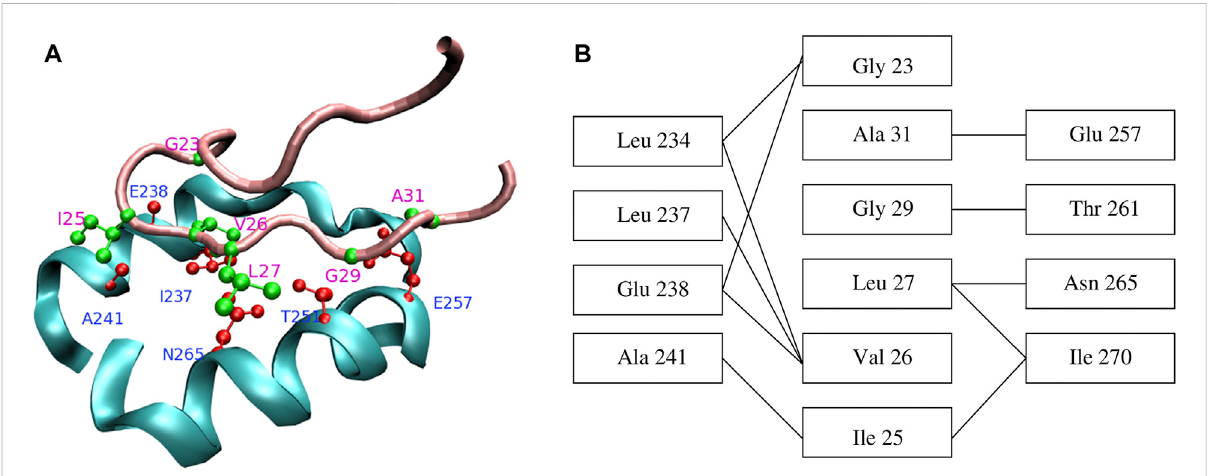
FIGURE 4 (A) Contacts between GroEL helices H and I (cyan) and the GroES mobile loop (pink). Sidechains of the residues that form the closest contacts are shown in red (GroEL) and green (GroES). (B) Schematic representation of contacts between GroEL and GroES. Reproduced from Ref (Stan et al.,